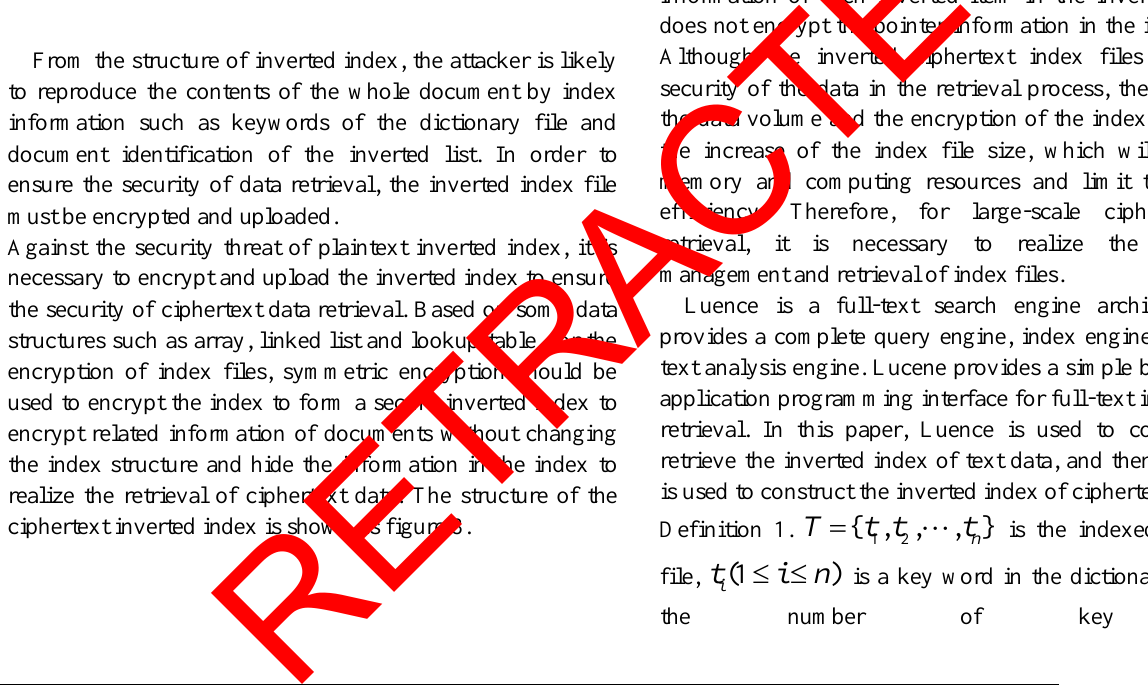
Algorithm 1 . Ciphertext inverted index construction